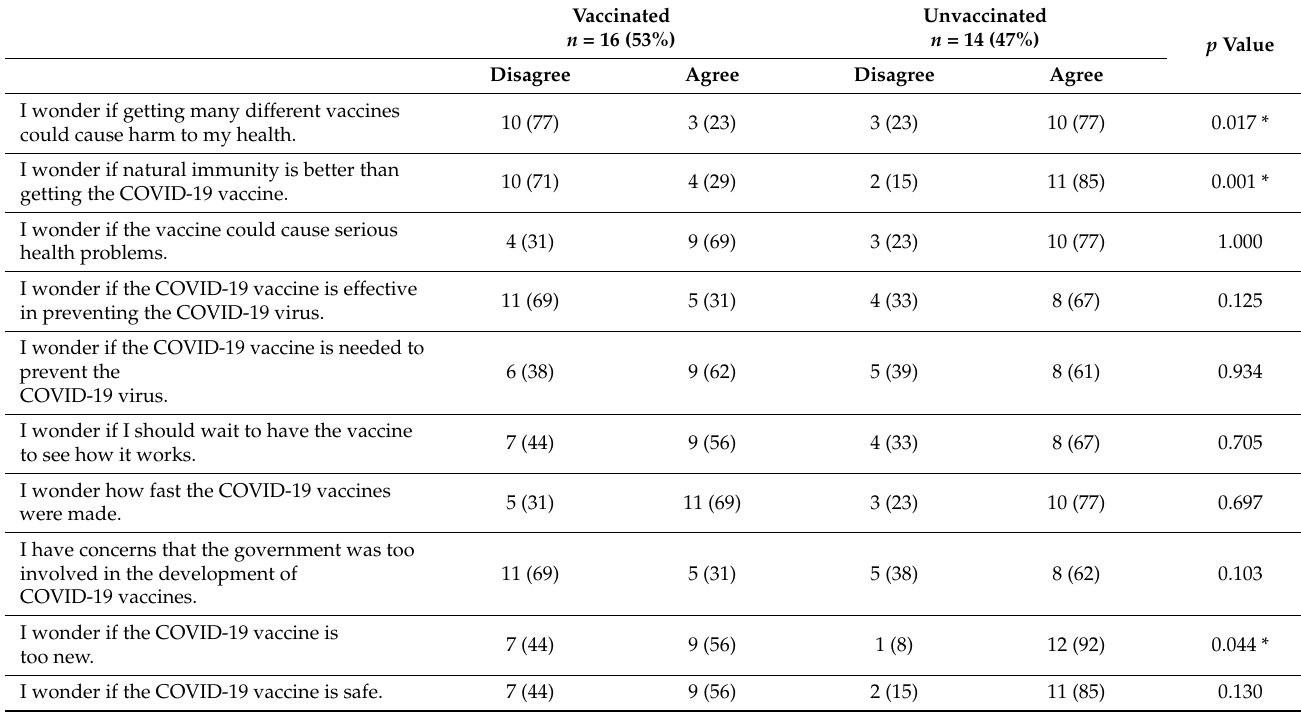
Table 2. Participant’s hesitant attitudes toward COVID-19 vaccines.